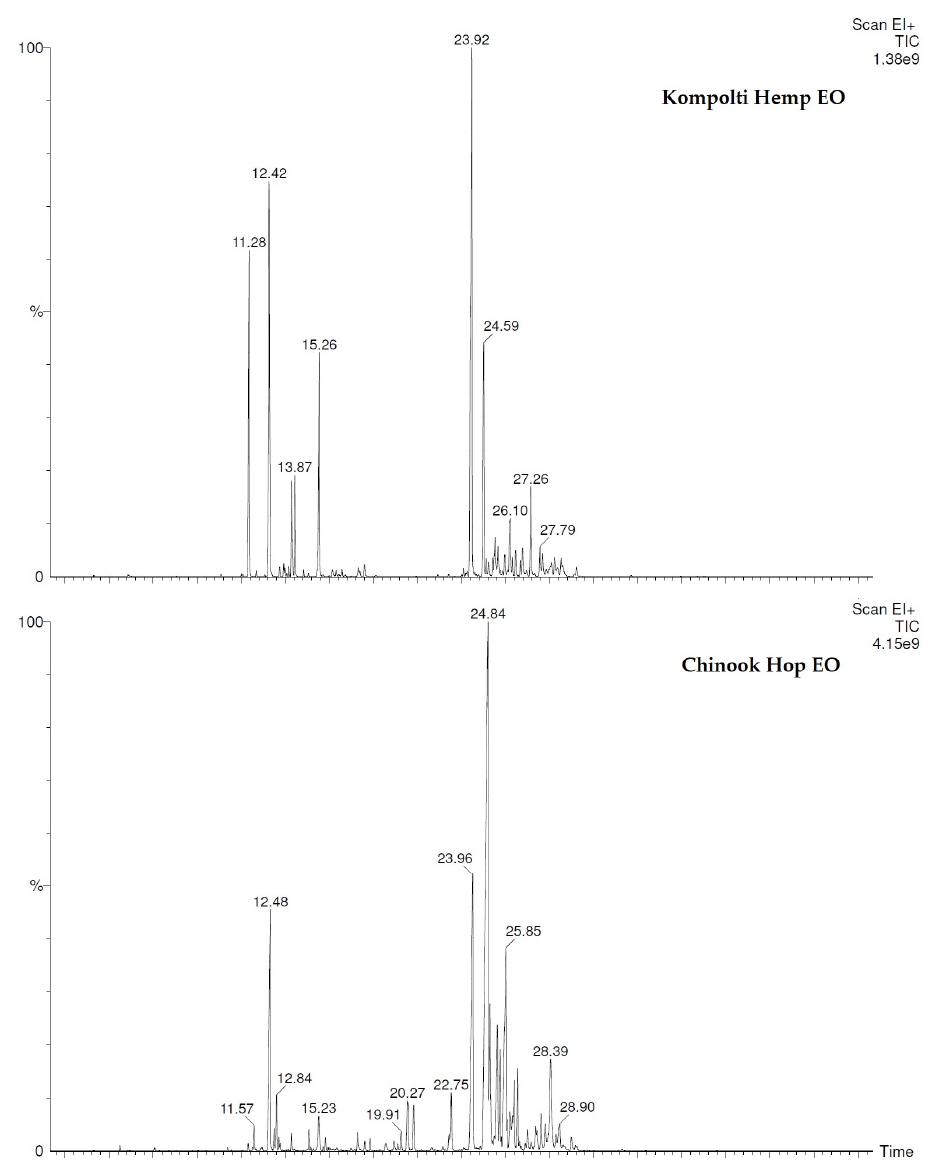
Figure 1. Chromatograms of hemp and hop EOs. The volatile composition of hop and hemp Hy carried out by HS-GC-MS technique highlighted the presence of 29 compounds, 20 in the hop Hy and 14 in that of hemp (Table 2). The chemical profile of the two Hys differed in that τ -cadinol (22.9%) followed by lin- alool (21.2%) and α -terpineol (12.7%) were the most abundant components of hop Hy, while α -terpineol (31.2%), cis - p -mentha-2,8-dien-1-ol (25.7%), and terpinen-4-ol (18.1%) were the ones in hemp Hy. Only five components, namely hexanal, linalool, isoborneol, terpinen-4-ol, and α -terpineol were detected in both Hys; moreover, sesquiterpenes such as caryophyllene oxide, τ -cadinol, germacrene D, and α -eudesmol, with percentage val- ues ranging from 1.2 to 22.9%, were characteristic only of the hop Hy. In general, the mon- oterpene content exceeded the sesquiterpene one. The chromatograms of both Hys are reported in Figure 2.